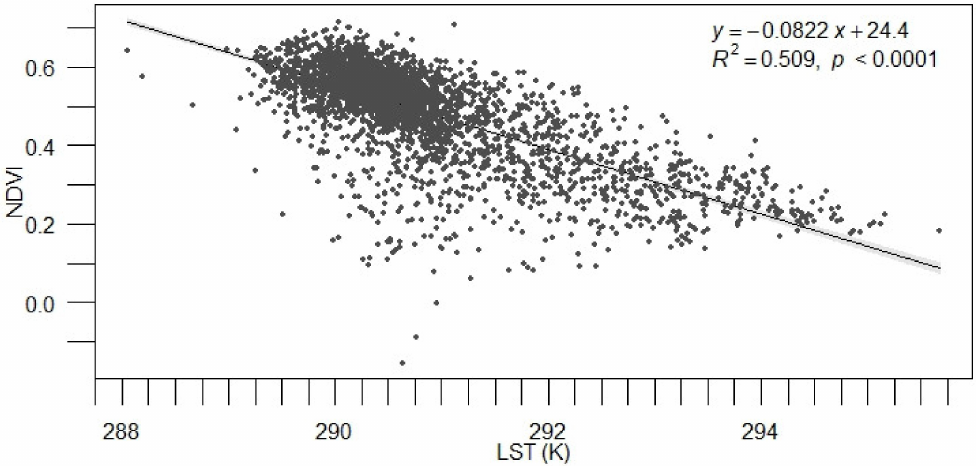
Figure 2. LST-NDVI scatter plot of the study area. LST and NDVI are chosen from corresponding LST (average of day and night) and NDVI raster of single day. The current plot shows the LST-NDVI negative correlation of 20 January